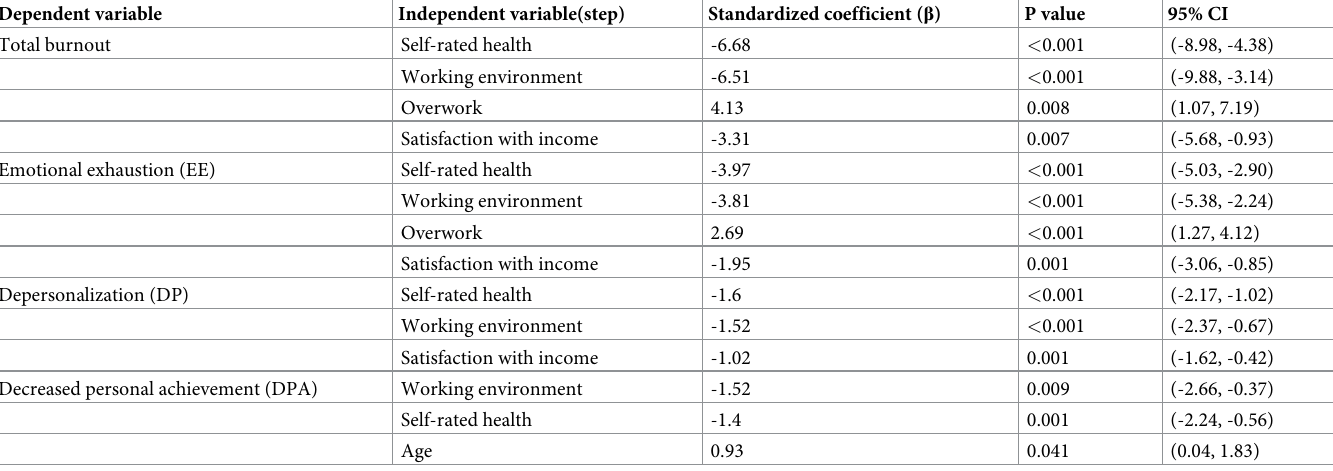
Table 3. Stepwise regression analysis of the influencing factors of burnout and its three dimensions (n =